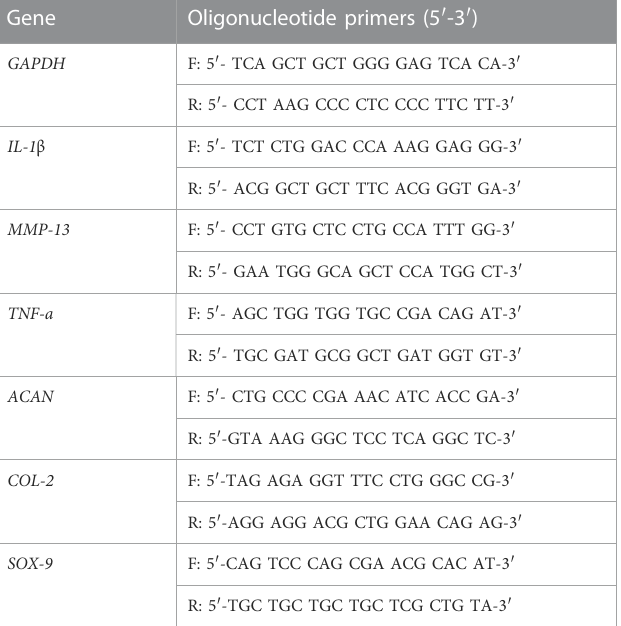
TABLE 1 Primer sequences of genes. Gene Oligonucleotide primers (5 ′ -3 ′